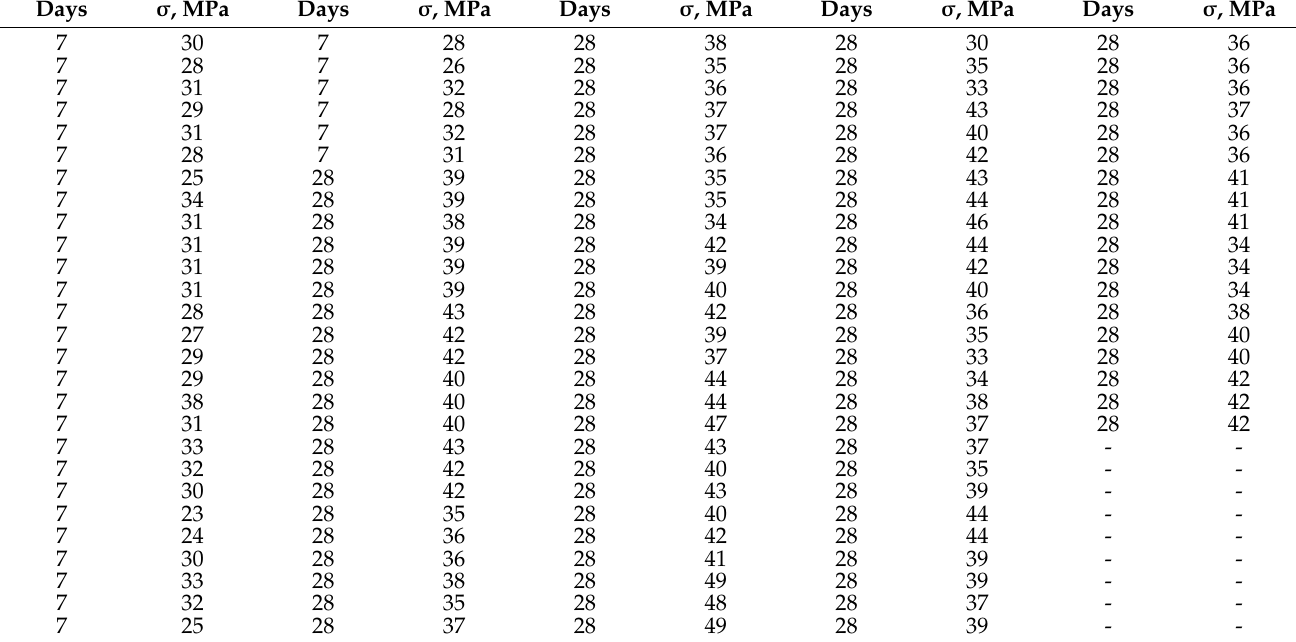
Table A1. Compressive strength of the concrete mixture f’ c = 28